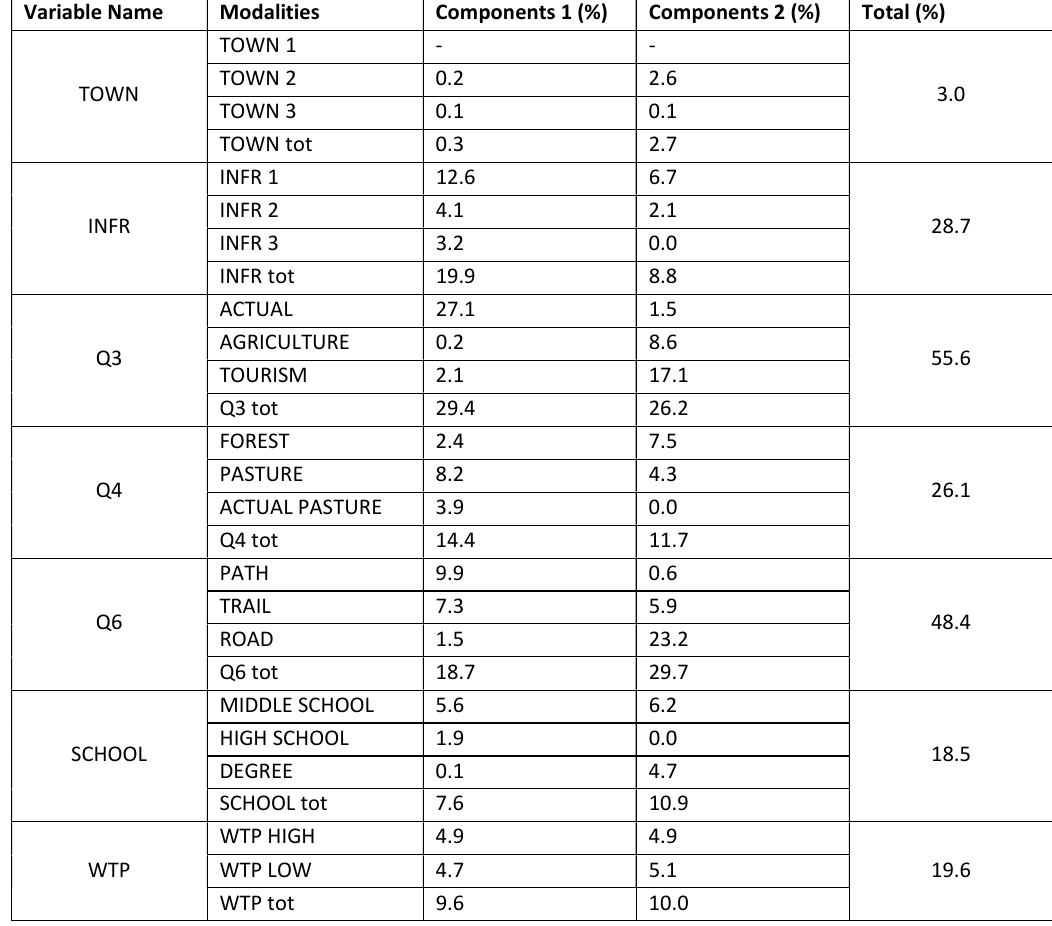
Figure 2: MCA variables divided by the two axes. Table 5: Contribution of the variables to the MCA first and second